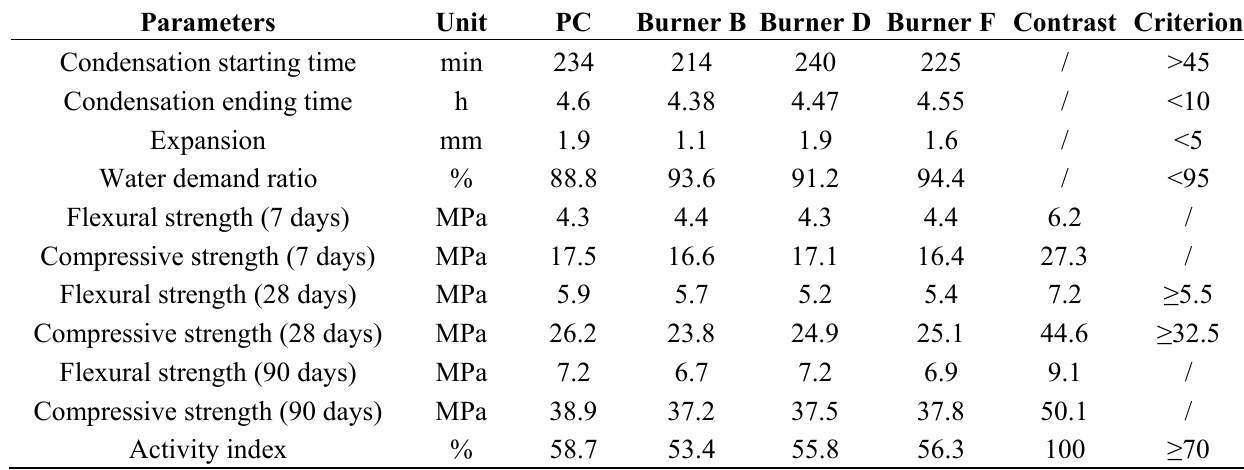
Table 3. Test results of key parameters for cement characteristics of fly